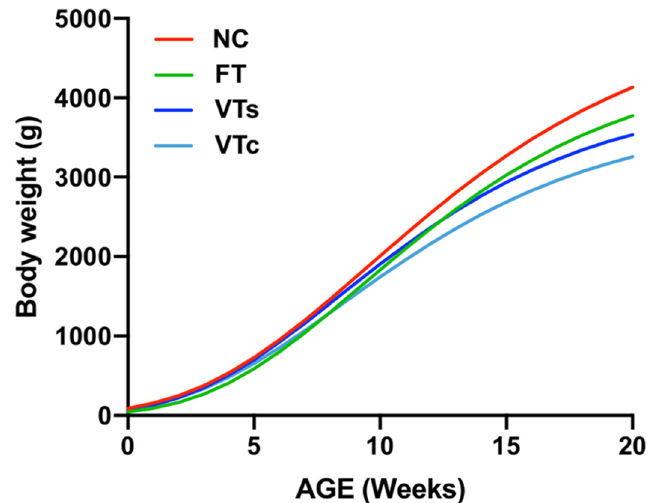
Figure 3. Growth curves: comparing differences between animals naturally conceived (NC) and those born after fresh embryo transfer (FT), vitrified embryo transfer using a ministraw (VTs), and vitrified embryo transfer using Cryotop (VTc).